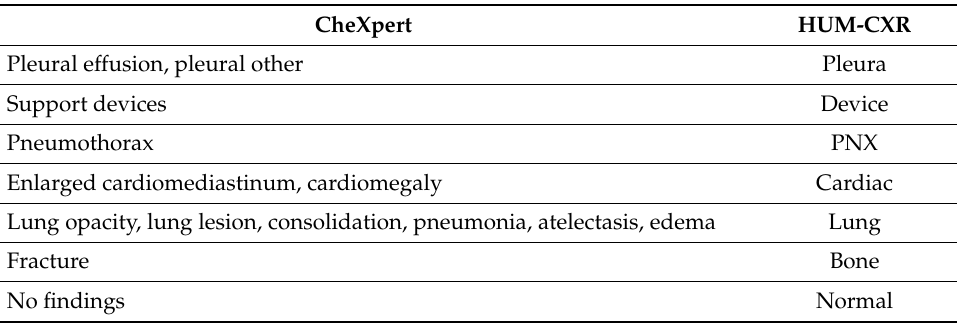
Table 3. Correspondence between CheXpert and HUM-CXR